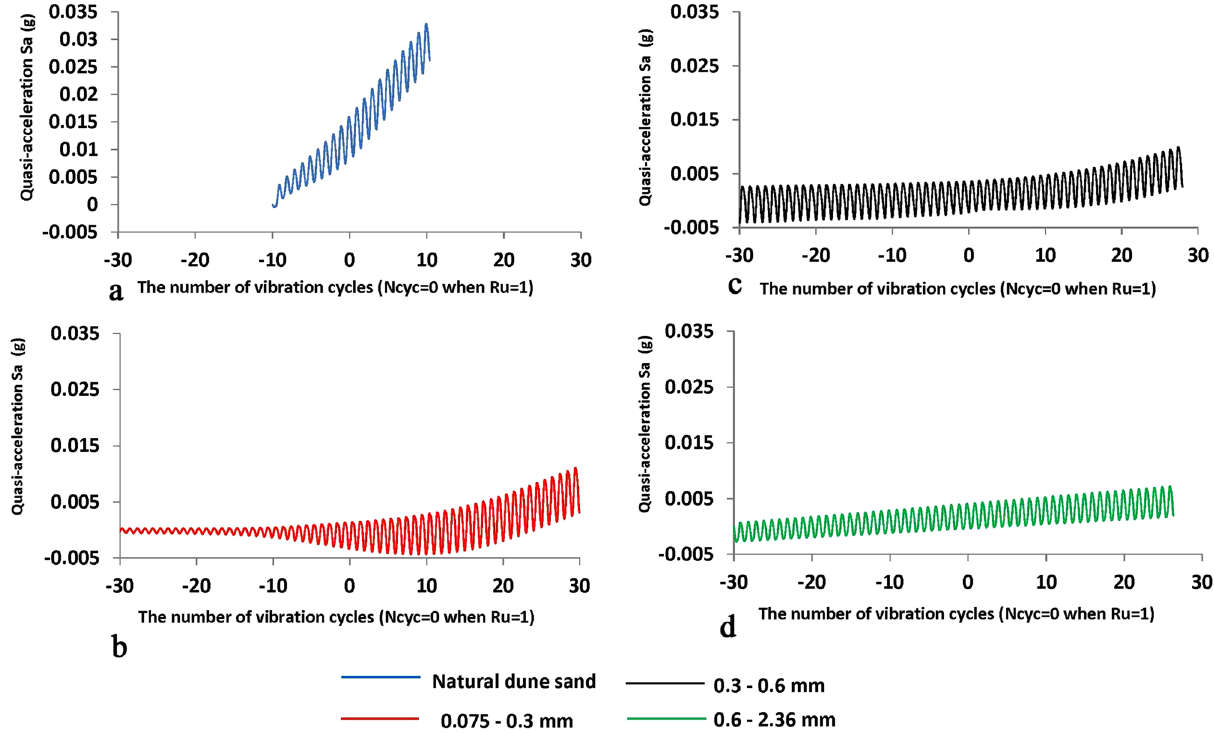
Figure 12. The changes of the value of quasi-acceleration Sa (g) vs. the number of vibration cycles N cyc for four sand samples under study, the X-values is the number of vibration cycles while 0 when the R u is reached to 1—Fig. 4 (the negative value of N cyc means the state before the liquefaction point while the positive values after the liquefaction point), the values of quasi-acceleration in g units. The blue, green, black, and red lines are for natural dune sand, fractions 2.36–0.6, 0.6–0.3, 0.3–0.075 mm,